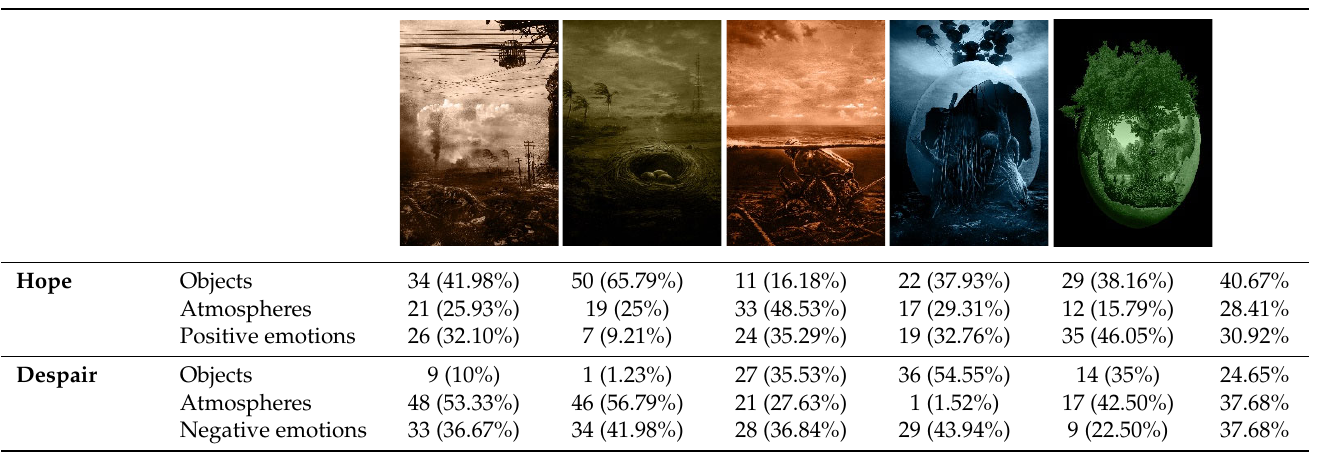
Table 5. Percentage of objects, atmospheres, and emotions on monochrome images expressing hope and despair.